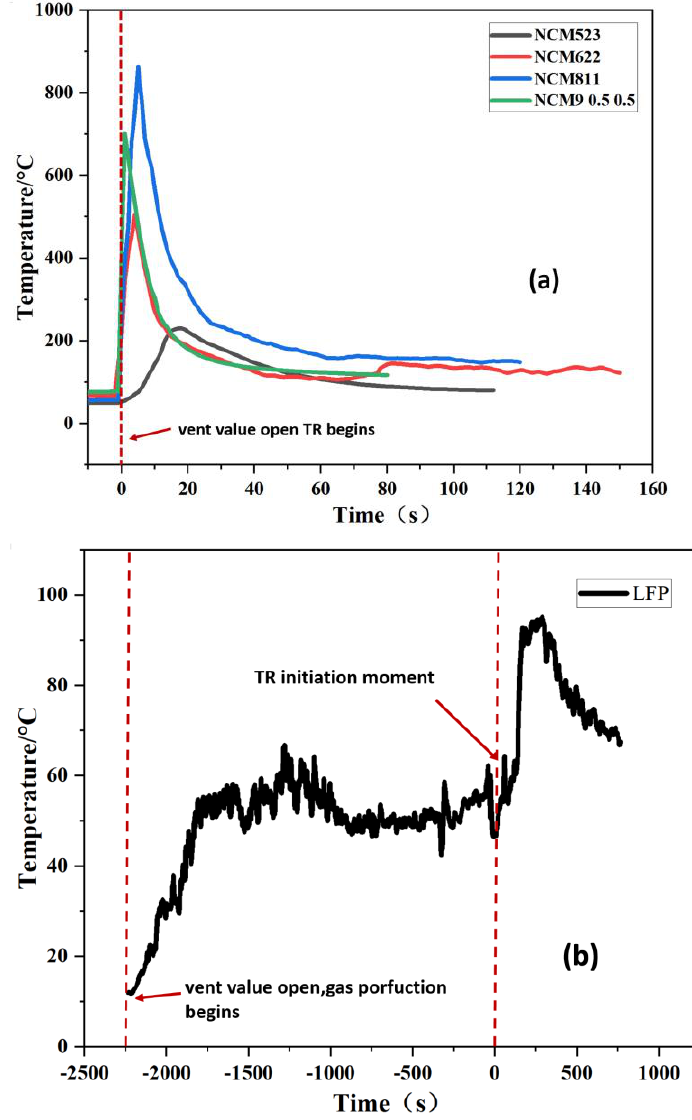
Figure 7. Subfigure ( a ) shows the temperature variation curve of the thermocouple at 30 mm above the vent valve of NCM523, NCM622, NCM811, and NCM9 0.5 0.5 batteries during the experiments. Subfigure ( b ) shows the temperature variation curve of the thermocouple at 30 mm above the vent valve of the LFP battery during the experiments.